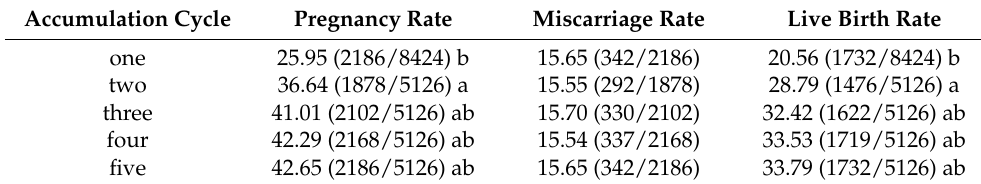
Table 2. Clinical outcomes of AI-D cumulative cycle during 2014–2019.